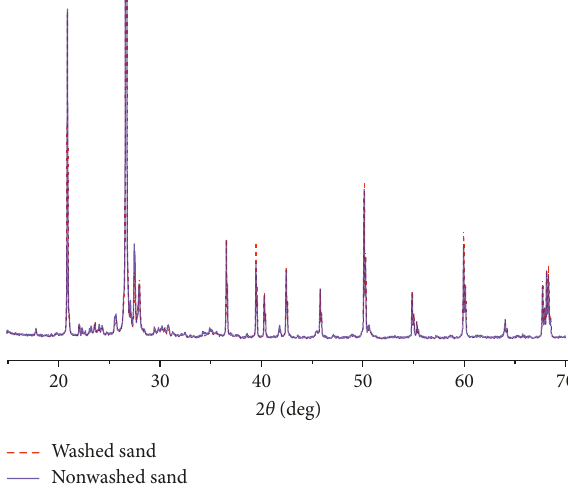
Figure 3: XRD profile comparison between washed (WM) and nonwashed mineral